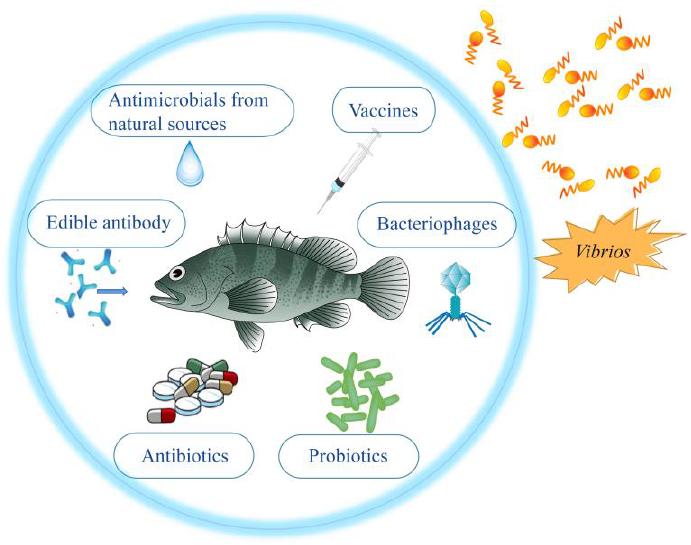
Figure 1. Strategies for prevention and control of vibriosis in Asian fish culture mentioned in this review.